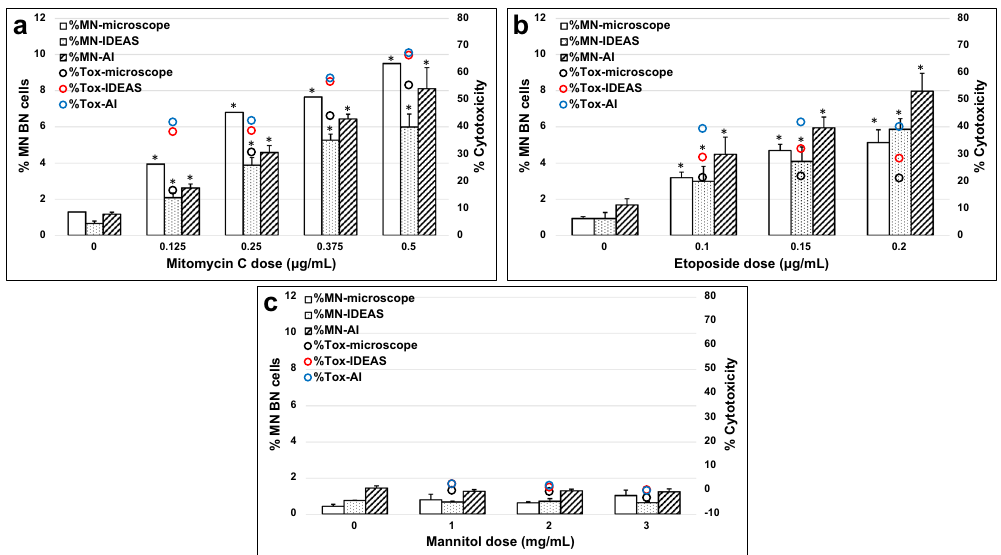
Fig. 4 Genotoxicity measured in the Cyt-B version of the MN assay. The percentage of MNed BN cells by microscopy (clear bars), IDEAS (dotted bars), and Amnis AI (striped bars), as well as cytotoxicity measured by microscopy (black circles), IDEAS (red circles), and Amnis AI (blue circles) are shown following a 3 h exposure and 24 h recovery for: ( a ) Mitomycin C (MMC), ( b ) Etoposide and ( c ) Mannitol. Statistically signi fi cant increases in MN frequency compared to solvent controls are indicated by asterisks (* P ≤ 0.001).